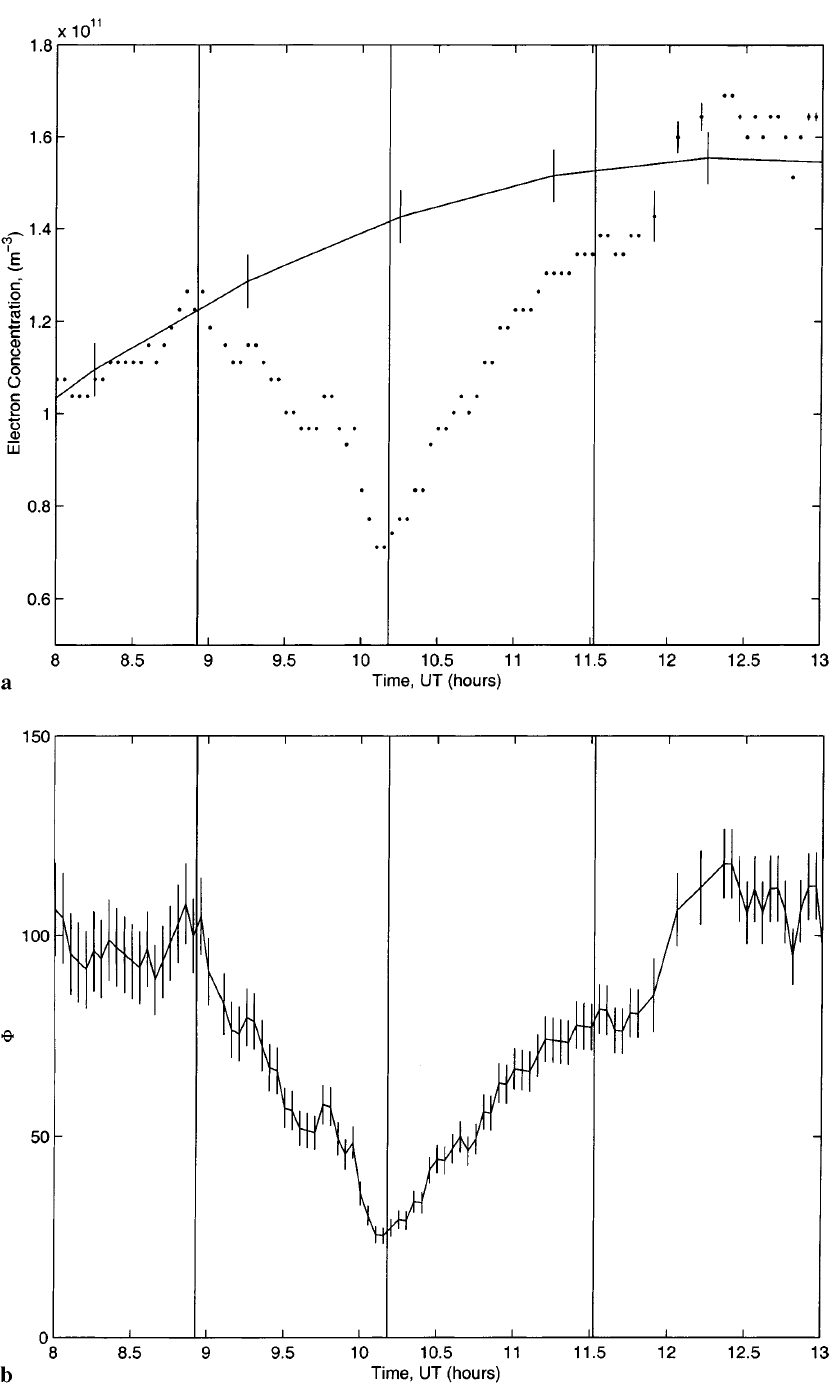
Fig. 3. a Electron concentration measure- ments along with the scaled ‘‘control day’’ curve for the duration of the 1999 eclipse. Note that in this figure, the control day data have now been scaled by a factor of 0.9 to best match the data prior to the eclipse. The three vertical lines indicate the times of first, second and fourth contact at 100 km with respect to the photosphere. b The obscura- tion function, U (in %) for the duration of the 1999 eclipse. U reaches a minimum value of 25